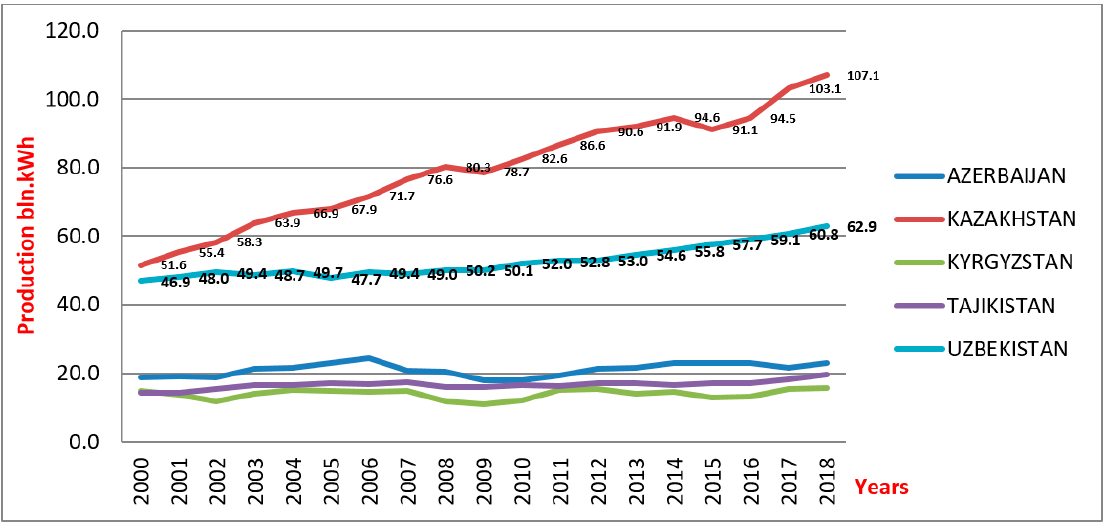
Figure 1. Production of electricity, bln. kWh.